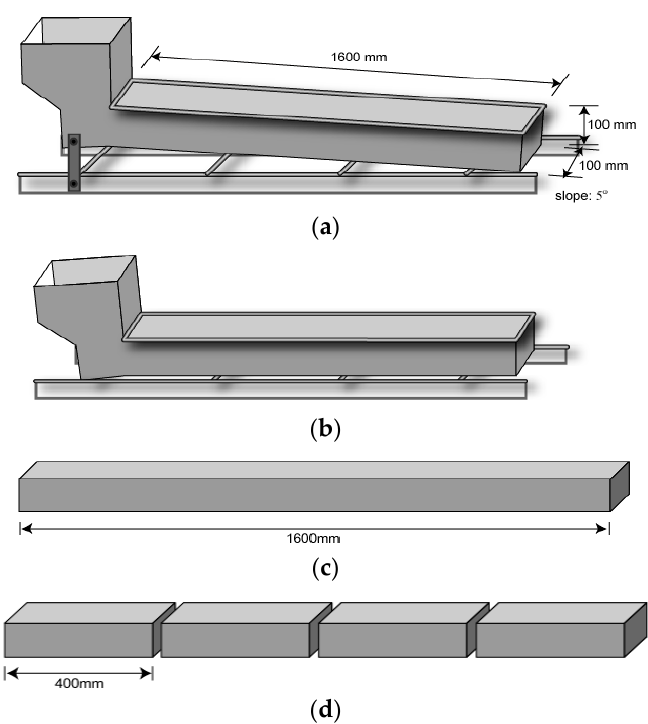
Figure 5. Procedure of specimen preparation; ( a ) a device for manufacturing a long beam with one-side placing; ( b ) on a level surface after placement; ( c ) beam specimen after demolding; and ( d ) divided small specimens after cutting.